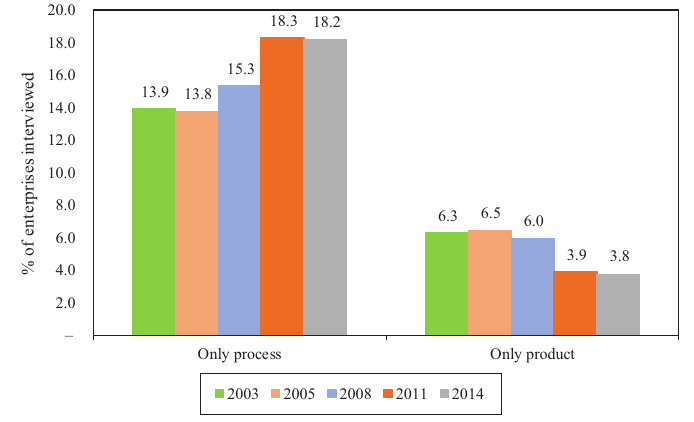
Figure 2. Percentage